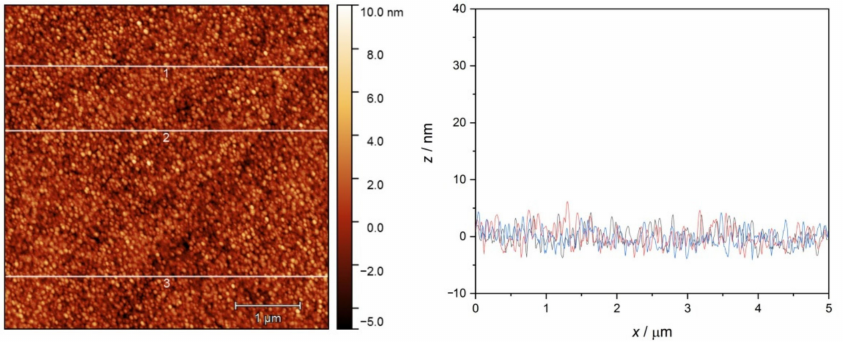
Figure 10. AFM image of the unmodified gold QCM sensor surface and line profiles at three selected positions (1 (black), 2 (red), 3 (blue)).